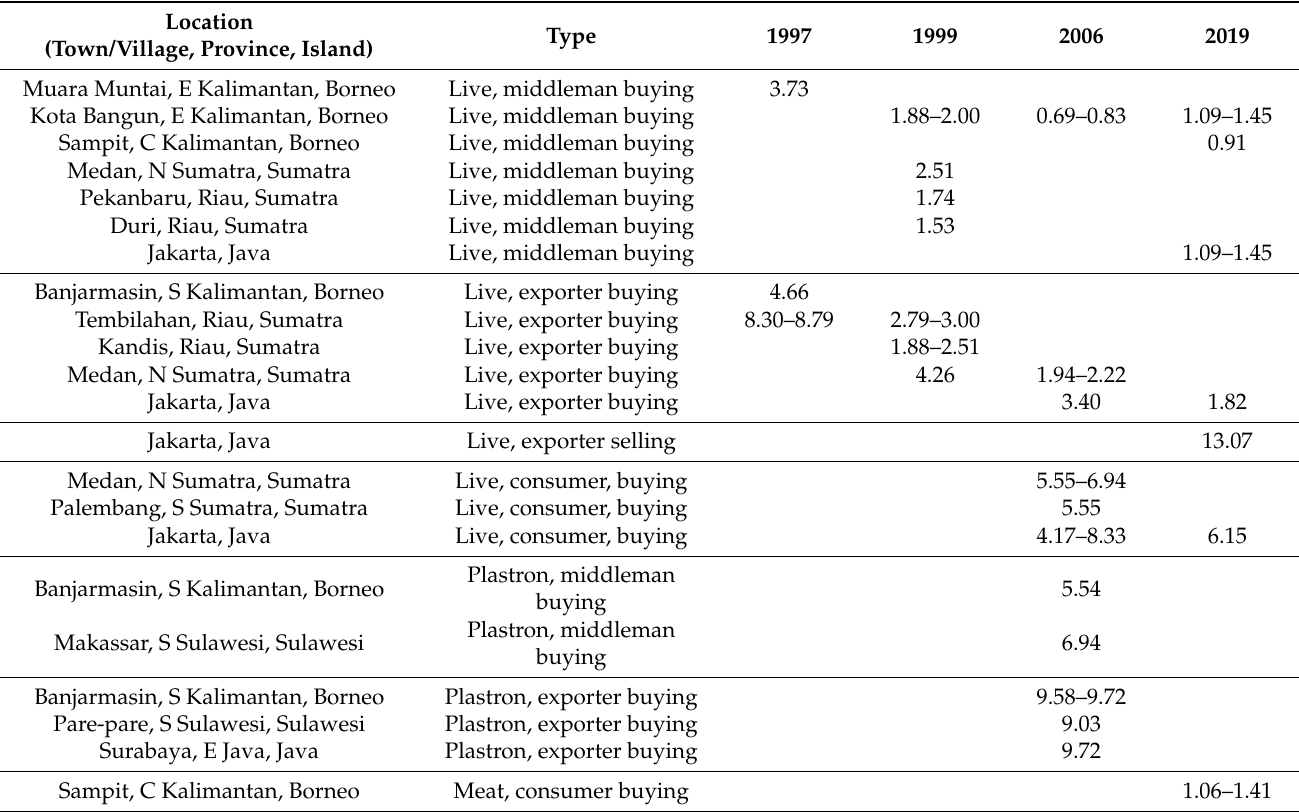
Table 2. Prices, in USD, of Southeast Asian box turtles Cuora amboinensis , or their parts, in western and central Indonesia, adjusted for inflation to December 2021. All prices are per kilogramme. Sources: V. Nijman unpublished data